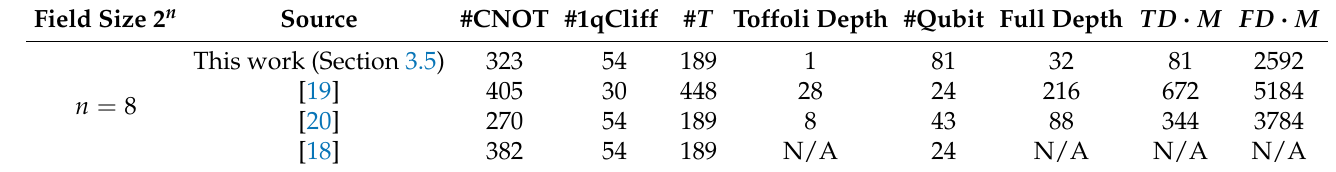
Table 7. Evaluation of quantum resources needed for multiplication of F 2 8 / ( x 8 + x 4 + x 3 + x + 1 ) . Field Size 2 n